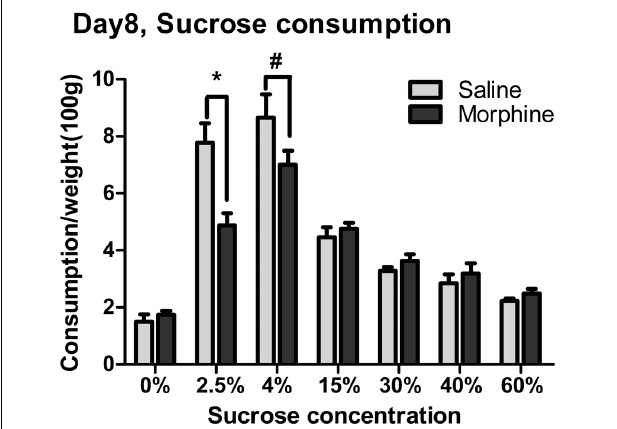
FIGURE 3 | The effects of morphine withdrawal on free consumption of varying concentrations of sucrose solution from a single bottle. Sucrose consumption in 1-h session was assessed under food-deprivation on day 8 of withdrawal. ∗ P < 0 . 05, #0.05 < P < 0 . 01, relative to saline group tested with the same concentration of sucrose solution. Values are mean ± s.e.m.